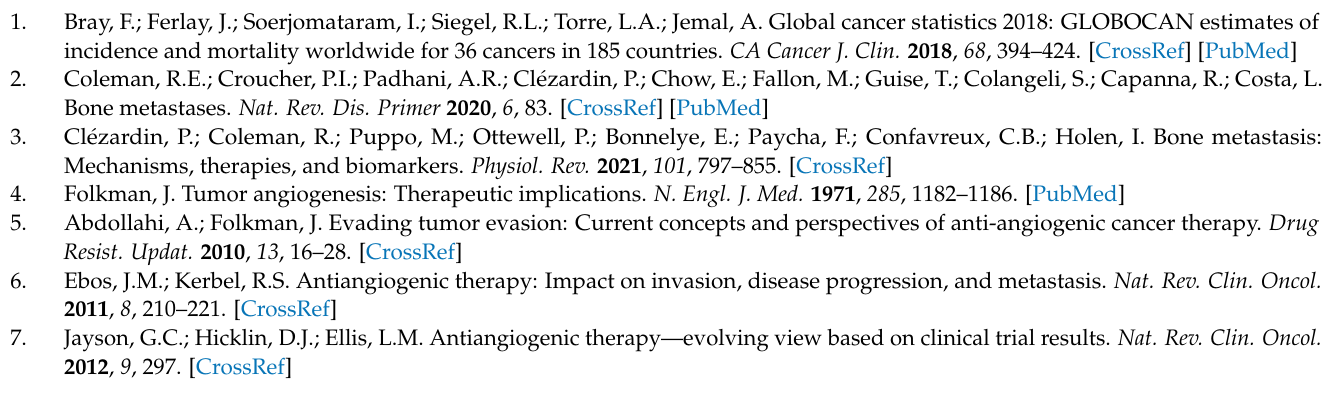
right one stands for the pre-processing result, after reorientation, cropping and bounding box. Figure S2: “Tubeness” enhancement of the 3D vascular network. (a) original image, in which sinu- soids appear buried due to the leaks of contrast agent as indicated by red arrow; (b) vascular network with “Tubeness” enhancement, in which the leaks and the recovery of sinusoids are improved as indicated by red arrow. Figure S3: Illustration of metastases on trabecular bone. Figure S4: Slices of a 3D original image (left) and the generated total volume (right). Figure S5: Illustration of the resulting marrow cavity (red), trabecular bone (yellow), and cortical bone (blue) in one slice. Supplementary-2, video: Partitions of blood vessels: arteries/arterioles/veins. Supplementary-3: 3D renderings